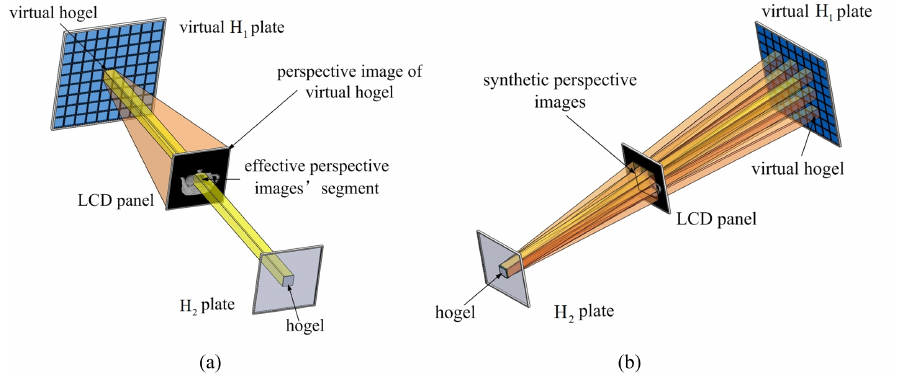
Figure 5. Holographic element-based effective perspective image segmentation and mosaicking methods ( a ) The extraction of effective perspective image segment corresponding to a single virtual hogel ( b ) The synthetic effective perspective image mosaicked by effective images segments of multiple virtual hogels.